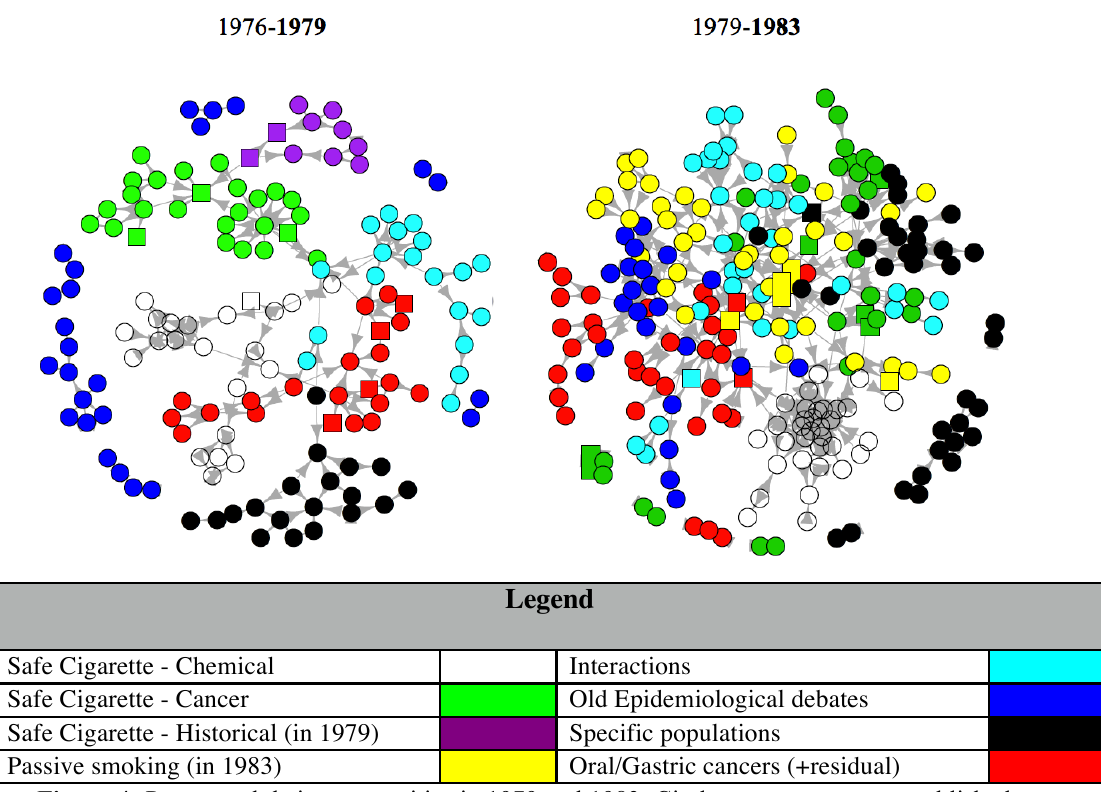
Figure 4: Papers and their communities in 1979 and 1983: Circles represent papers published in the observation period or cited by those papers, connected by citations, laid out with the Fruchterman-Reingold algorithm. Papers first-authored by Ernst Wynder are marked by a square, and papers first-authored by Takeshi Hirayama or Dimitri Trichopoulos are marked by a rectangle. Colors represent communities. Isolates were removed from the graphical presentation but not from the analysis. The high modularity in 1979 is apparent in the clear segregation between communities, which are well defined, except for the blue community of old epidemiological debates, which is composed of old citations and a residual category. By 1983, communities are more intertwined, marked by the passive smoking community (yellow), which bridges the passive smoking communities and diffuses through much of the network. By 1983, the black and green communities of specific populations and the quest for a safe cigarette, respectively, become less defined and present the internal clustering characteristic of a fading community and residuals.